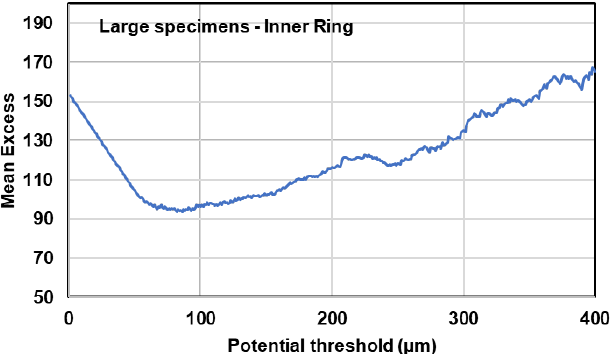
Figure 18. Mean excess plot using µCT data in large specimens in inner ring.